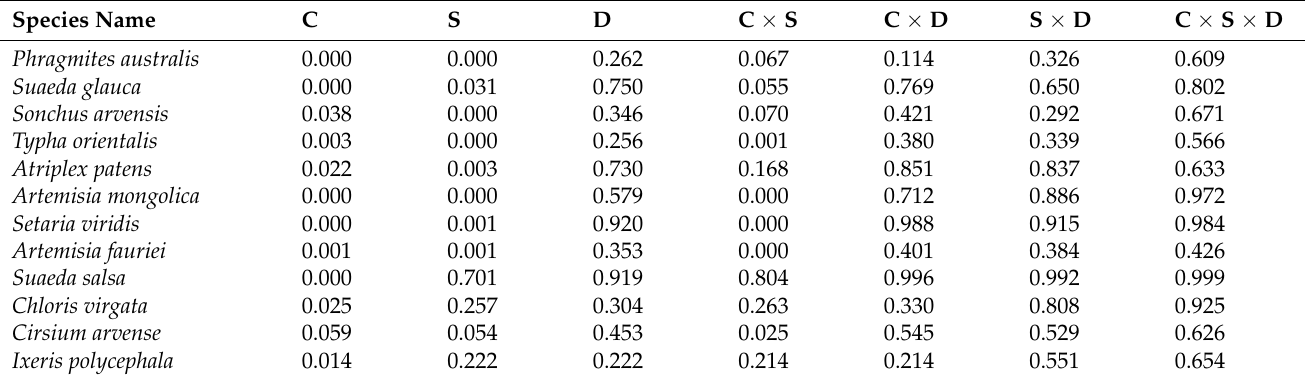
Table 6. Three-way ANOVA of the effects of community type, salinity, and diesel concentration on the seedling numbers of the dominant species in the